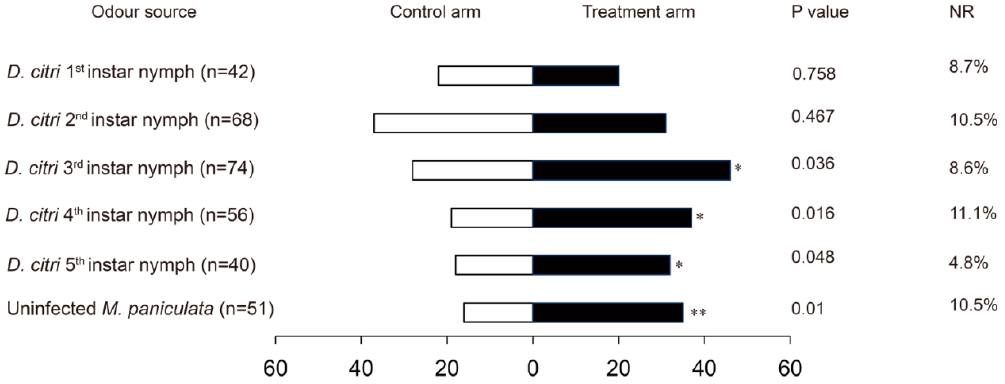
Figure 2. Response of male Tamarixia radiata to odours emitted from Diaphorina citri nymphs versus blank controls with a Y-tube olfactormeter. NR: percentage of non-responders.